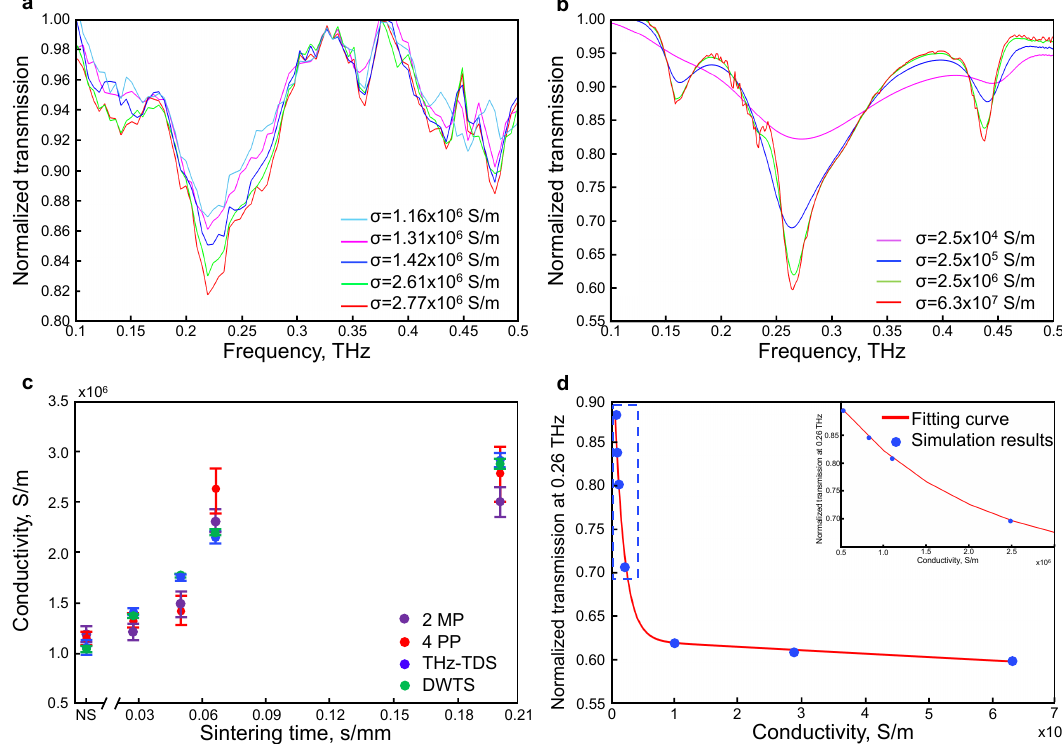
Figure 3. ( a ) normalized transmission spectra of experimental results; ( b ) simulated normalized transmission spectra with finite difference time domain (FDTD) method; ( c ) comparison of the conductivity values obtained by two microprobes (2MP) (violet), 4PP (red), normalized transmission from THz-TDS (blue) and DWTS (green) as a function of sintering time; ( d ) simulated transmission amplitude at 0.26 THz vs.